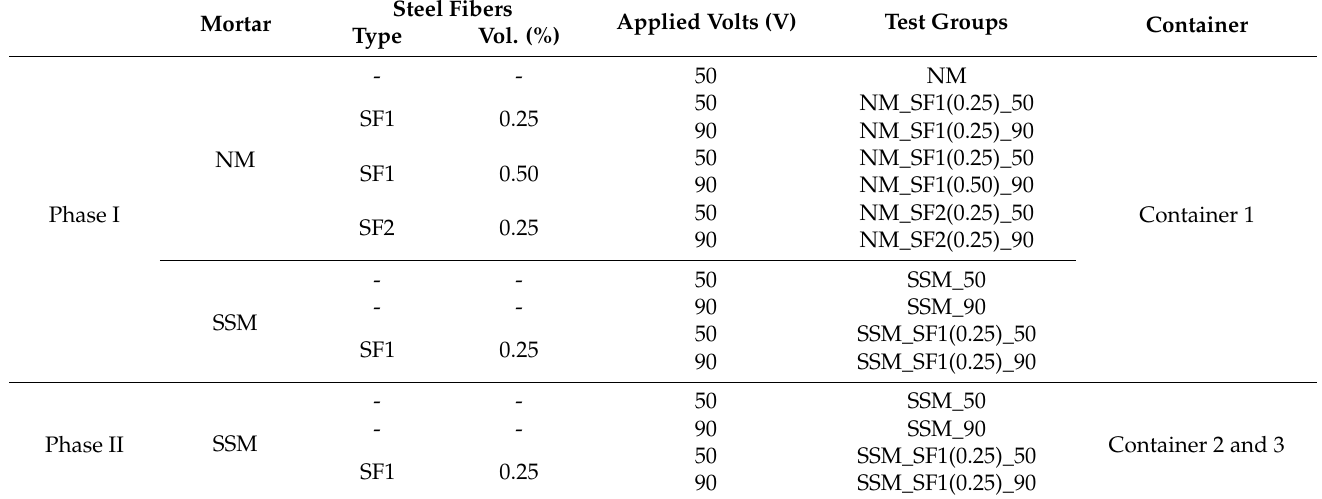
Figure 6. Test setup. Table 6. Summary of test mortar groups.